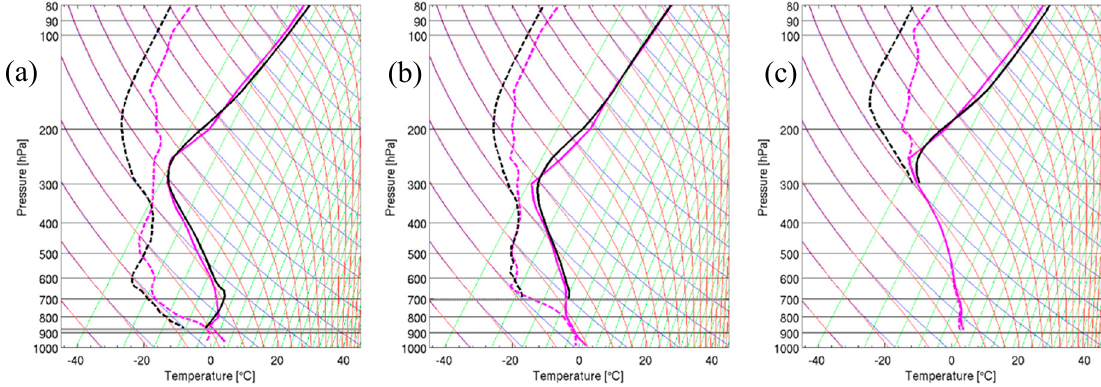
Figure 2. An example of temperature and dewpoint profiles for clear sky ( a ), above low cloud ( b ), above high cloud ( c ) as compared to the model background. Retrievals (black) and NCEP / GFS (magenta).